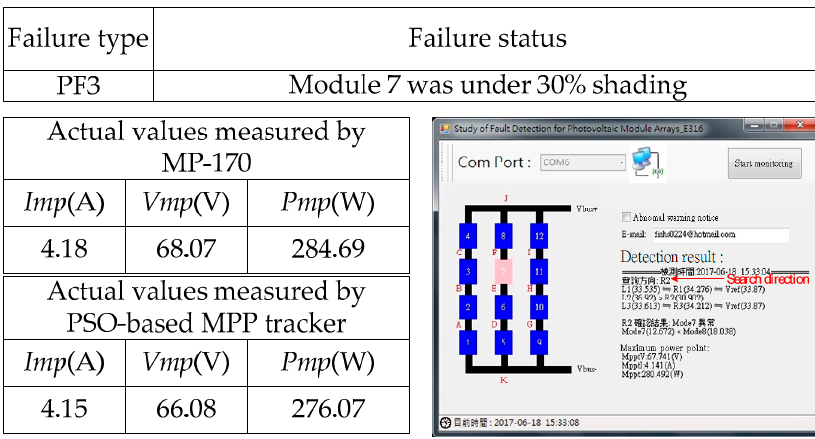
Figure 17. Experimental outcome for failure type PF2.